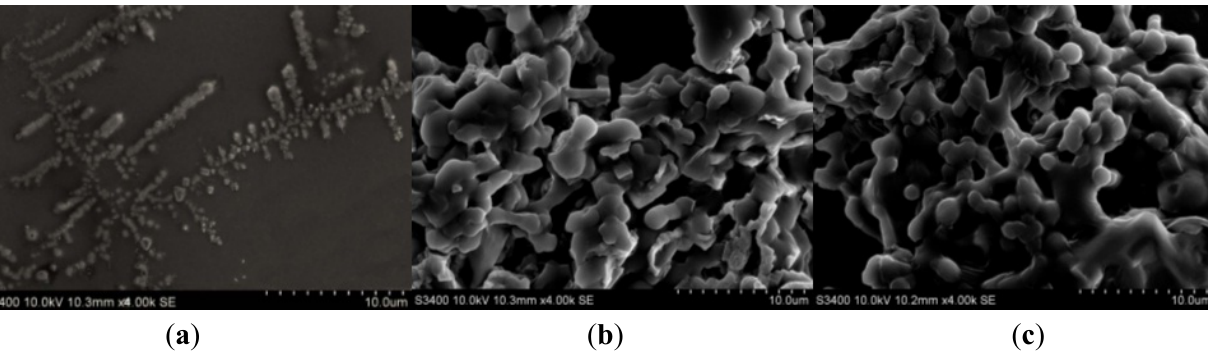
Figure 1. Scanning electron microscopy (SEM) images of ( a ) EnVision reagent (EV);